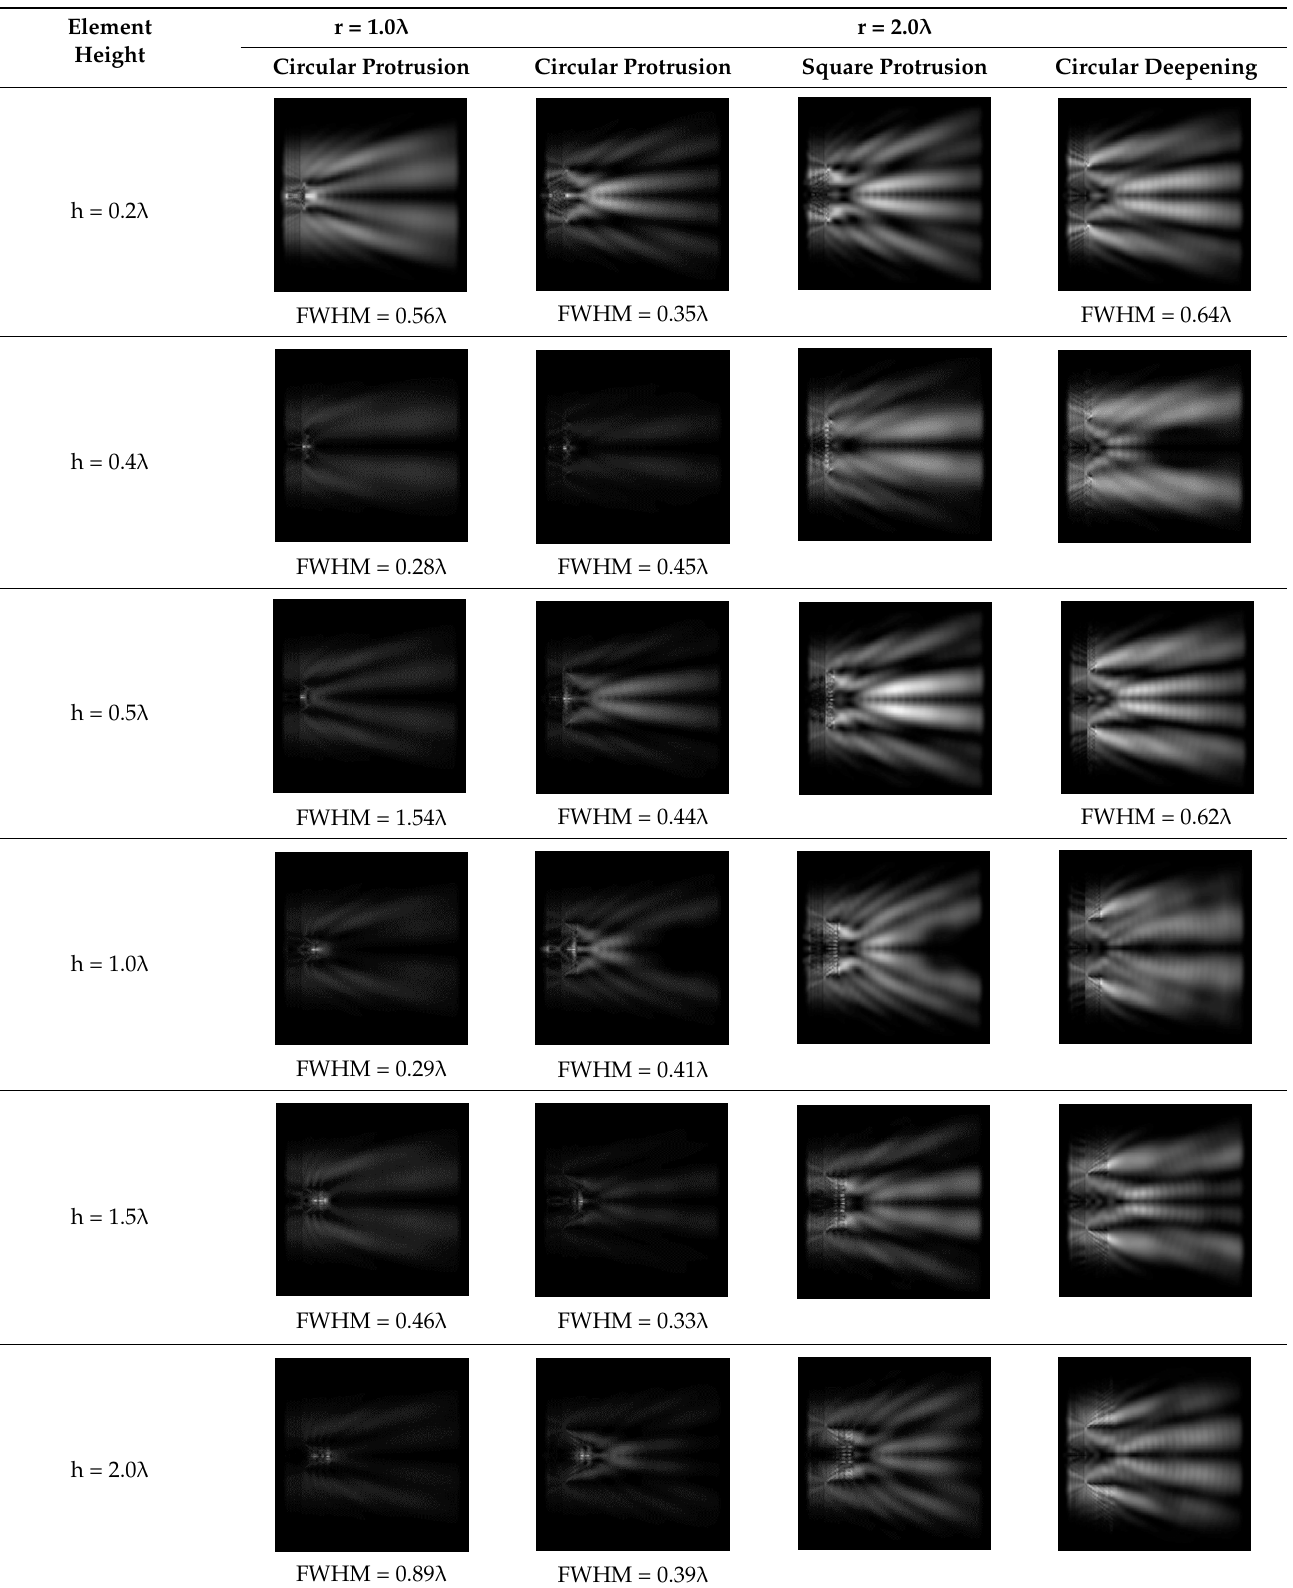
Table 4. The Laguerre–Gauss mode (0,1) diffraction by surface micro-defects with the variable height, plane xz, | E | 2 , [ − 6.96 λ ; 6.96 λ ].